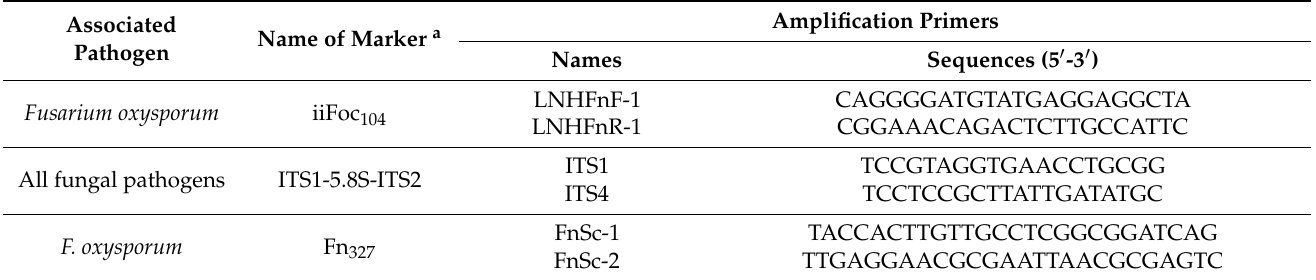
Table 11. Comparison of Fo iiPCR-, Fo qPCR-, and Fo cPCR-based in planta detection for field